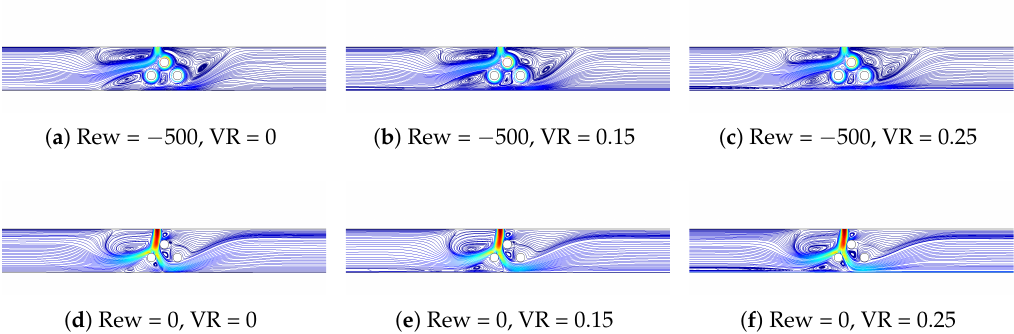
Figure 6. Effects of hot wall velocity on streamline variations for rotating and non-rotating CC cases (Ha = 5, Mx = − 1).